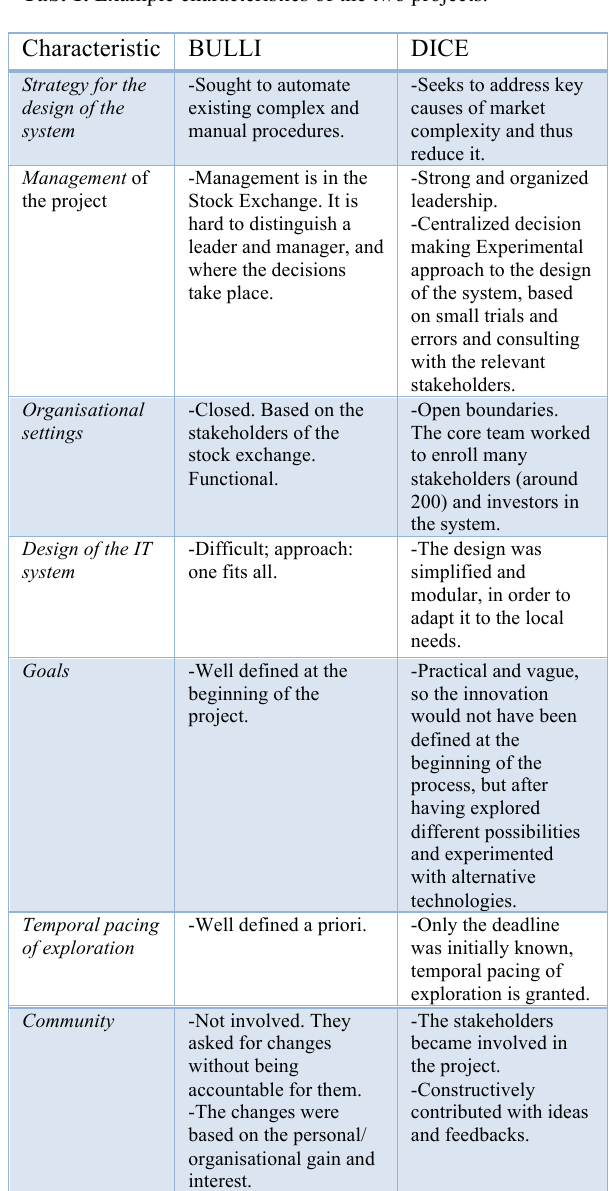
Tab. 1. Example characteristics of the two